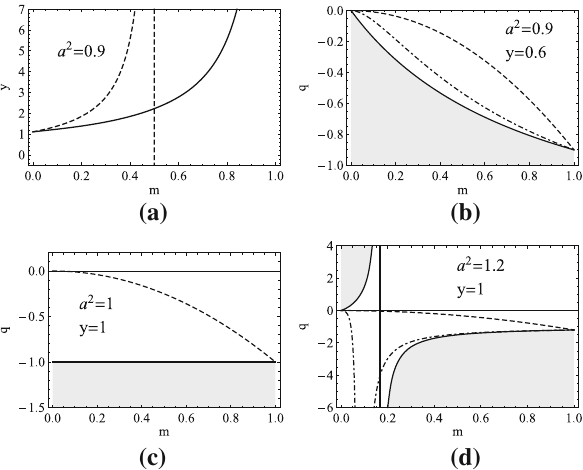
Fig. 1 The graphs of characteristic functions depicted for the given ( m ; a 2 ) (full curve) and y θ ( m ; a 2 ) (dashed parameters: a y θ d ( r ) d ( ex ± ) curve), the vertical line is the asymptote; b–d q θ r ( m ; y , a 2 ) (full curve), ( m ; a 2 ) (dashed curve), q θ ( m ; y , a 2 ) (dash-dotted curve) q θ ex ( + ) ex ( ± ) successively corresponding to cases y < 1 / a 2 , y = 1 / a 2 , y > 1 / a 2 . The unshaded region demarcates the definition range of the potentials X θ ± ( m ; q , y , a 2 ) given by conditions (29) and